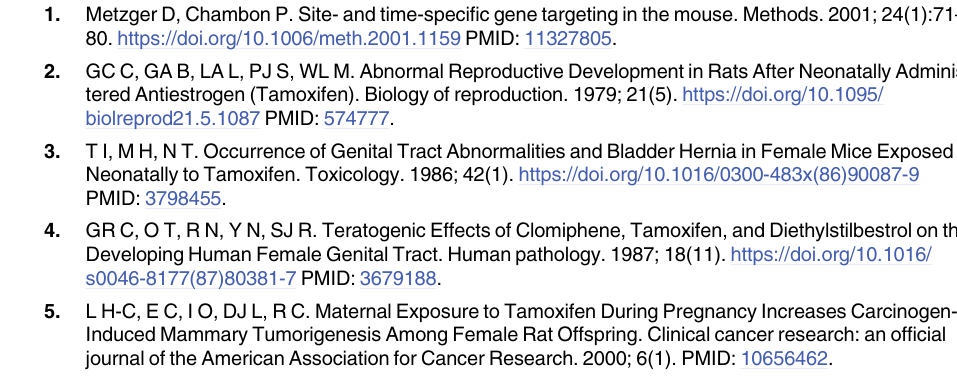
S1 Table. Descriptors of the Esr1 and Esr2 study populations. Female Esr1 +/- mice were mated with male Esr1 +/- mice, and female Esr2 +/- mice were mated with either Esr2 +/- or Esr2 -/- male mice. Timed-pregnant dams were administered 200 mg/kg of tamoxifen at gesta- tional day (GD)9.75. At GD17, dams were inspected for live fetuses and resorptions, and fetuses were measured for crown-rump length and genotyped from tail tissue. TAM, tamoxi- fen; SD, standard deviation. S2 Table. Incidence of malformations by genotype in Esr1 and Esr2 animals. Incidence of limb malformations, cleft palate, or limb malformations or cleft palate are listed for each geno- type and treatment group of the Esr1 and Esr2 study populations. TAM,